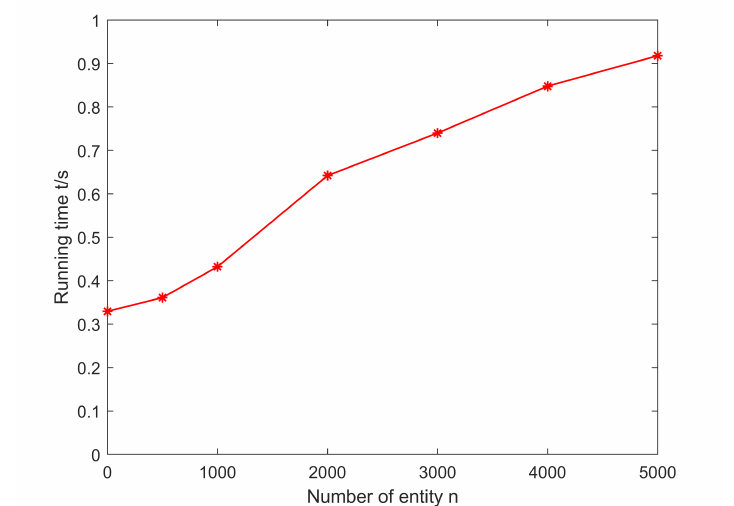
Figure 6. Running time of the algorithm in different numbers of